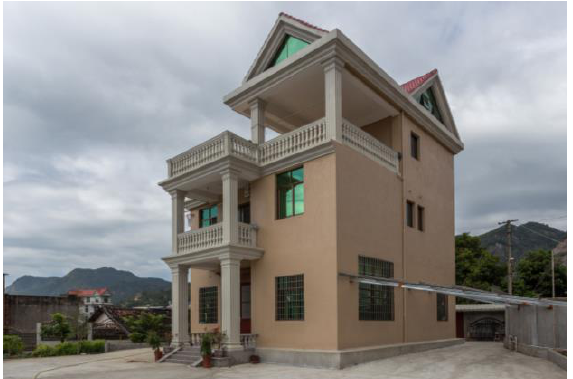
Figure 7. Sample of a recently built boxlike villa. Photo by the first